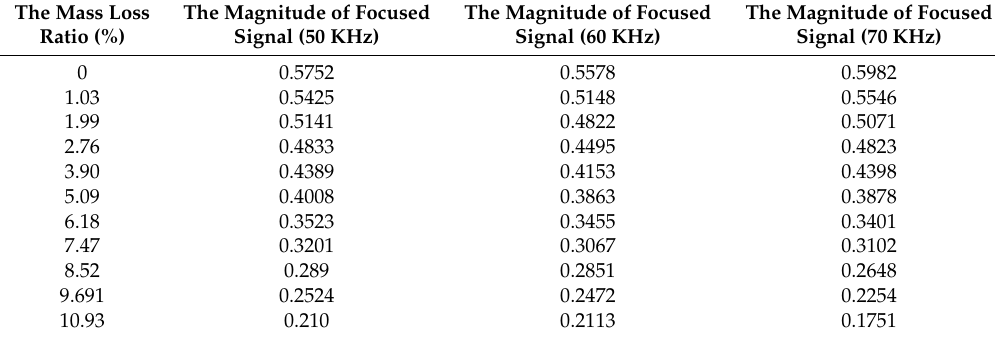
Table 3. The data of specimen no.